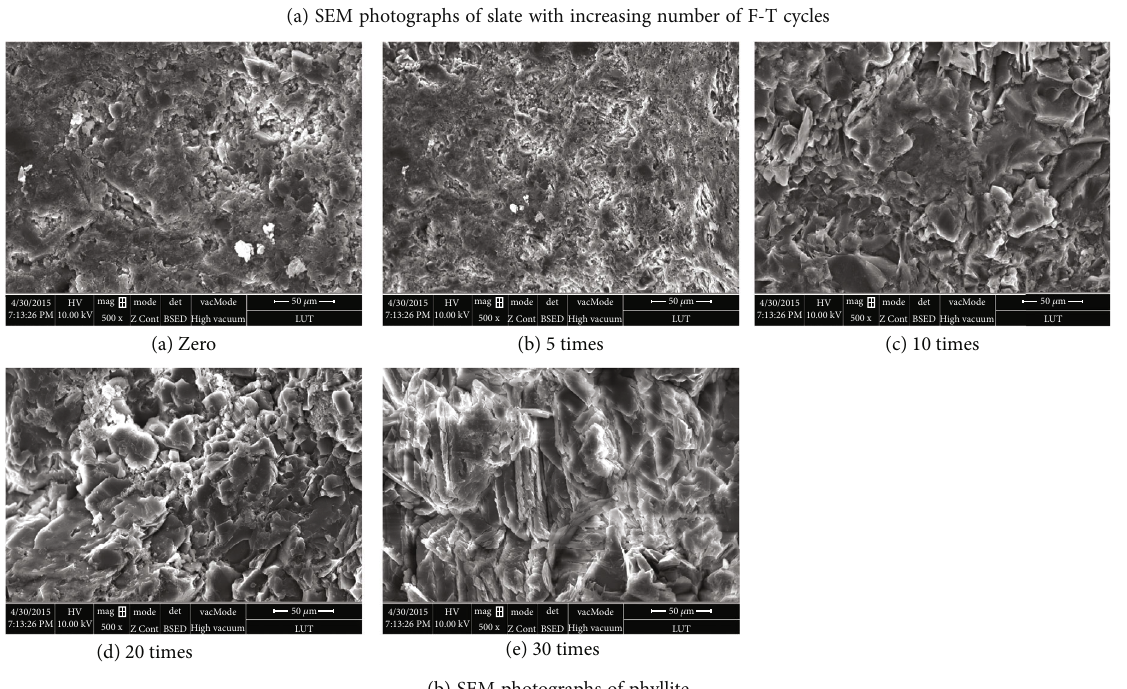
Figure 11: SEM photographs of two low-grade metamorphic